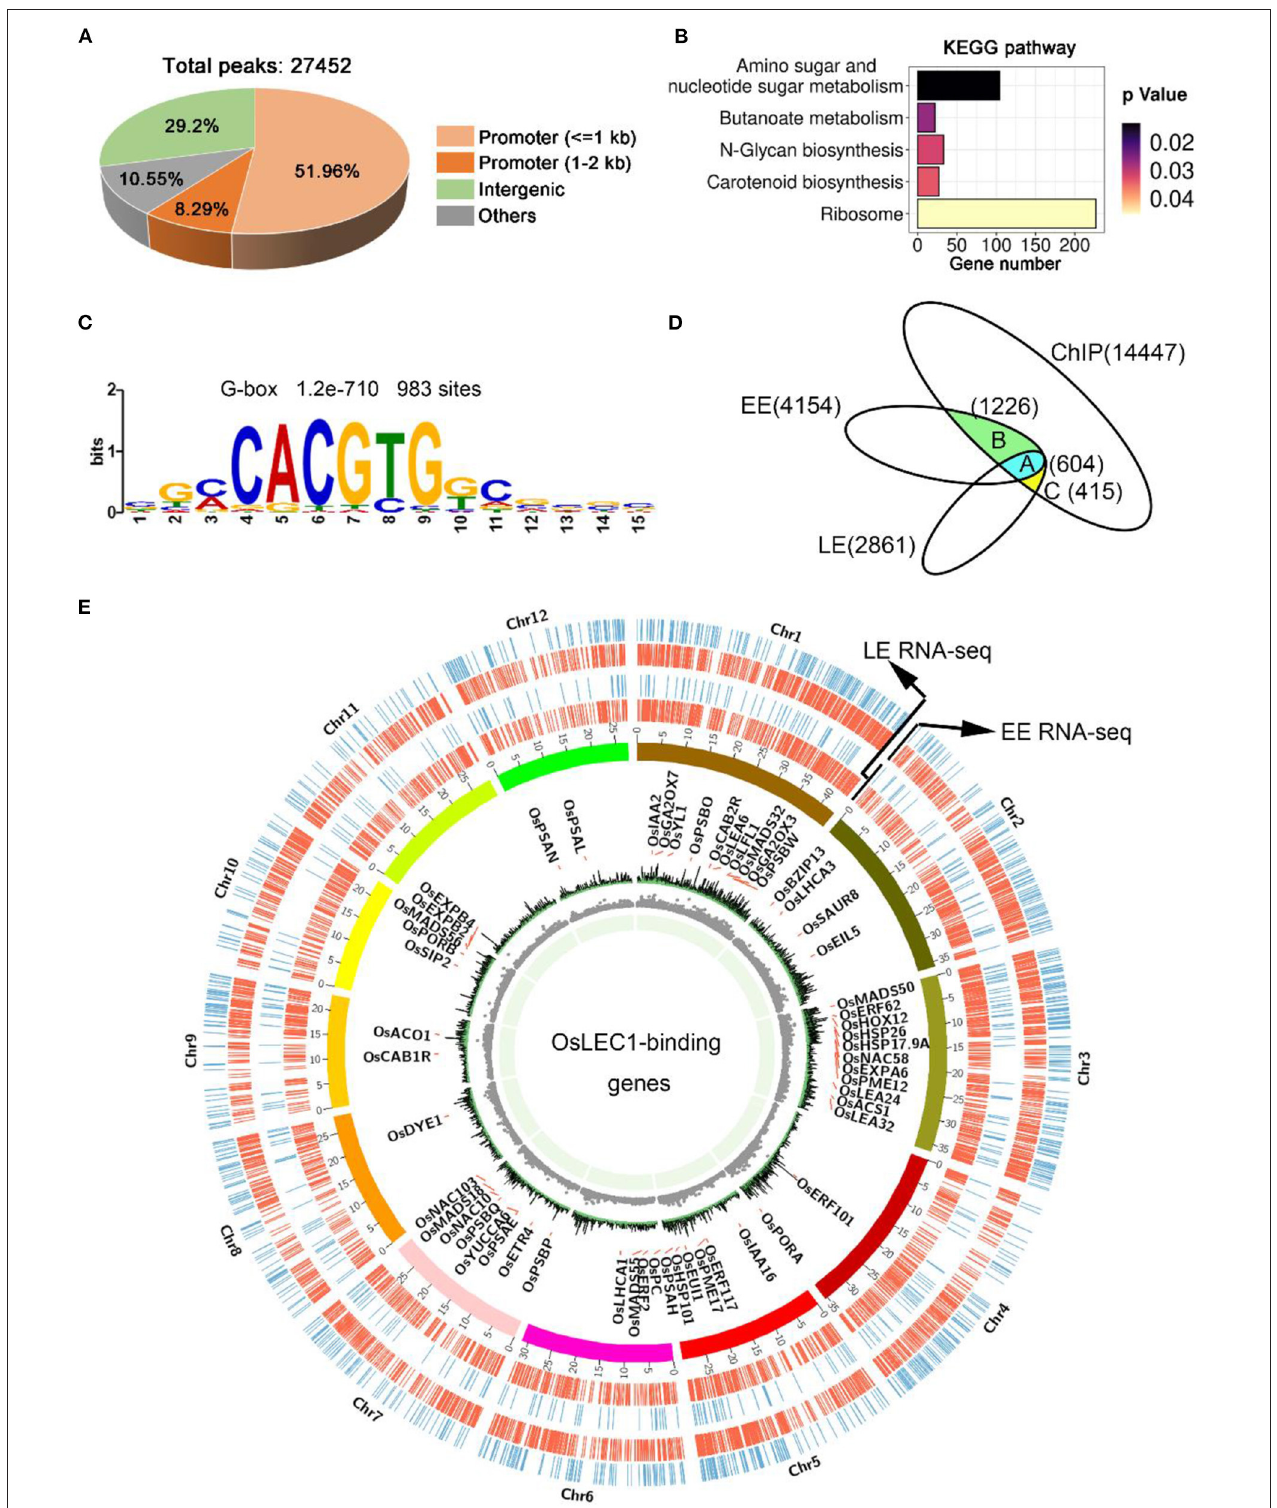
FIGURE 6 | OsLEC1-binding genes detected using ChIP-seq. (A) The distribution of peaks on the rice genome according to ChIP-seq results. (B) KEGG pathway analysis of OsLEC1-binding genes. (C) DNA sequence motif G-box that enriched in LEC1-bound genomic regions 1kb upstream of target genes, which were identified via de novo motif-discovery analyses. (D) Venn diagrams show the overlap between genes bound by OsLEC1 and differentially expressed genes in Oslec1-1